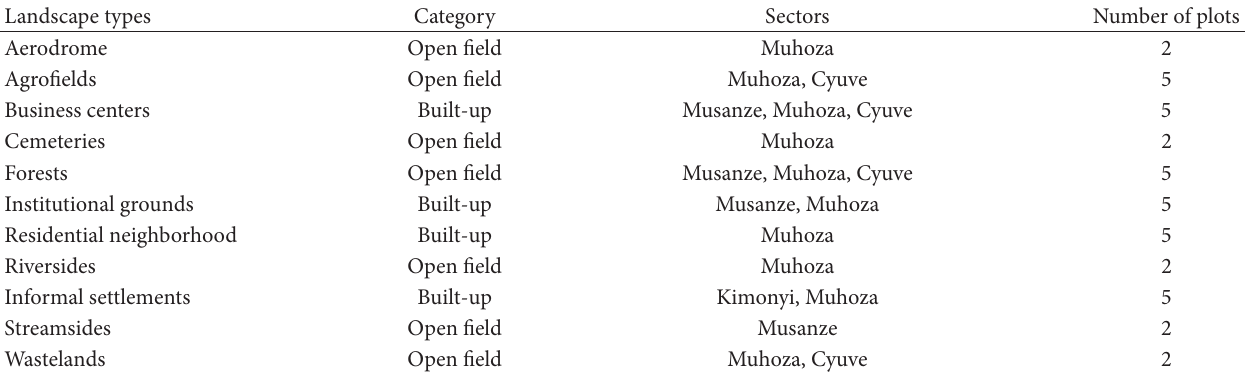
Table 1: Distribution of plots across microlandscape types and administrative